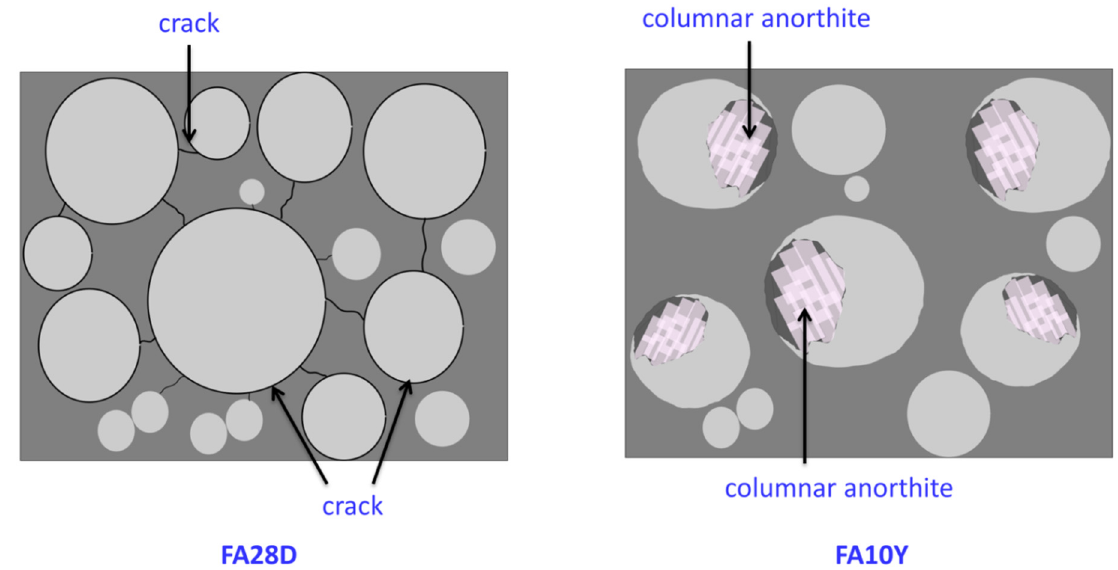
Figure 3. The transformation of fly ash particle after 28 days and 10 years of curing age.